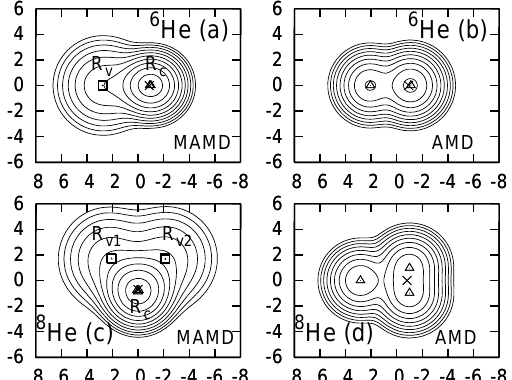
Fig. 2. Density distributions of 6 He and 8 He calculated with the intrinsic wave functions. Units on both axes are fm. Con- tour lines are plotted in logarithmic scale. Centers of Gaussian wave packets are plotted by symbols. Crosses represent the pro- ton wave packets, whereas triangles and squares represent the neutron wave packets that are narrow and wide, respectively. R c and R v in (a) and (c) denote the positions of localized wave pack-